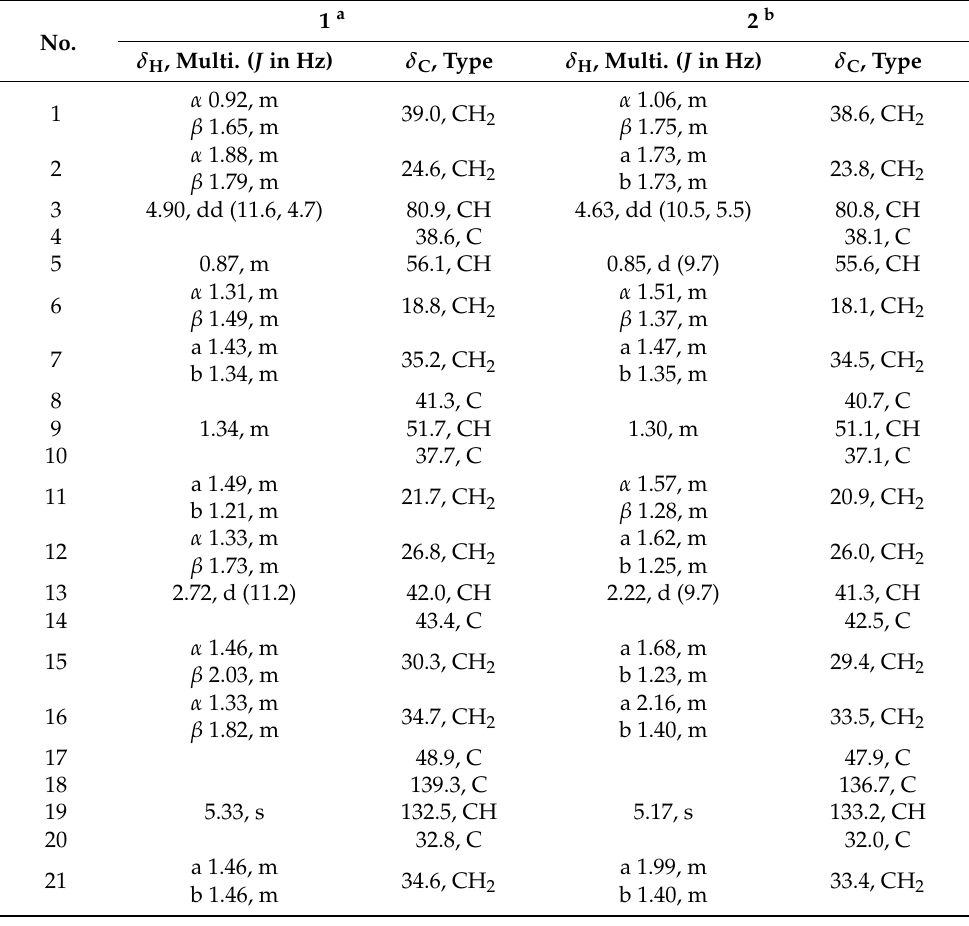
Table 1. 1 H (400 MHz) and 13 C (100 MHz) NMR data for 1 and 2 ( δ in ppm). 1 a 2 b No. δ H , Multi. ( J in Hz) δ C , Type δ H , Multi. ( J in